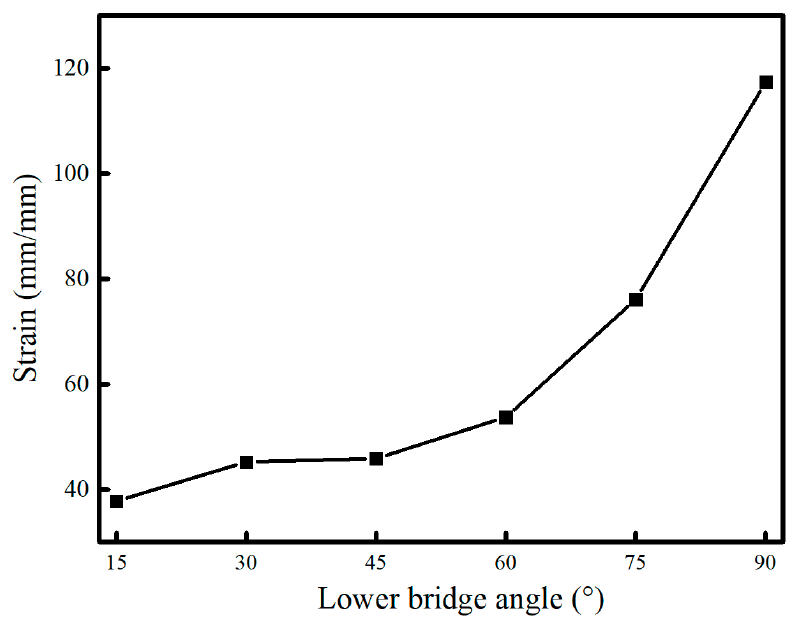
Figure 14. Model-predicted effect of lower bridge angle on the strain at the mid-thickness of weld seam after